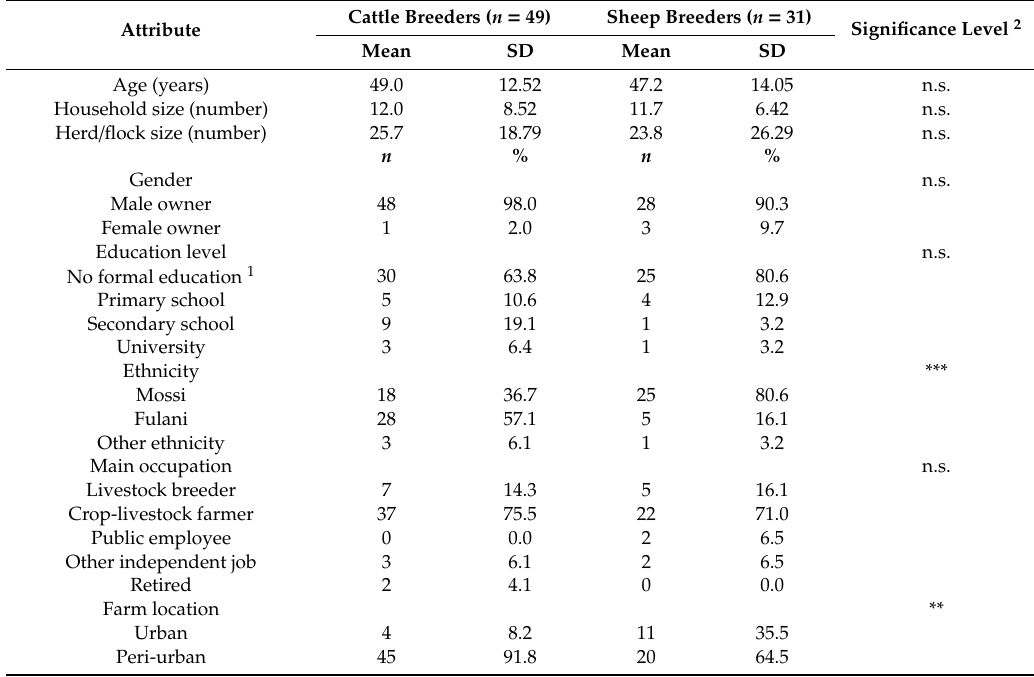
Table 1. Socio-economic characteristics of cattle and sheep breeders in